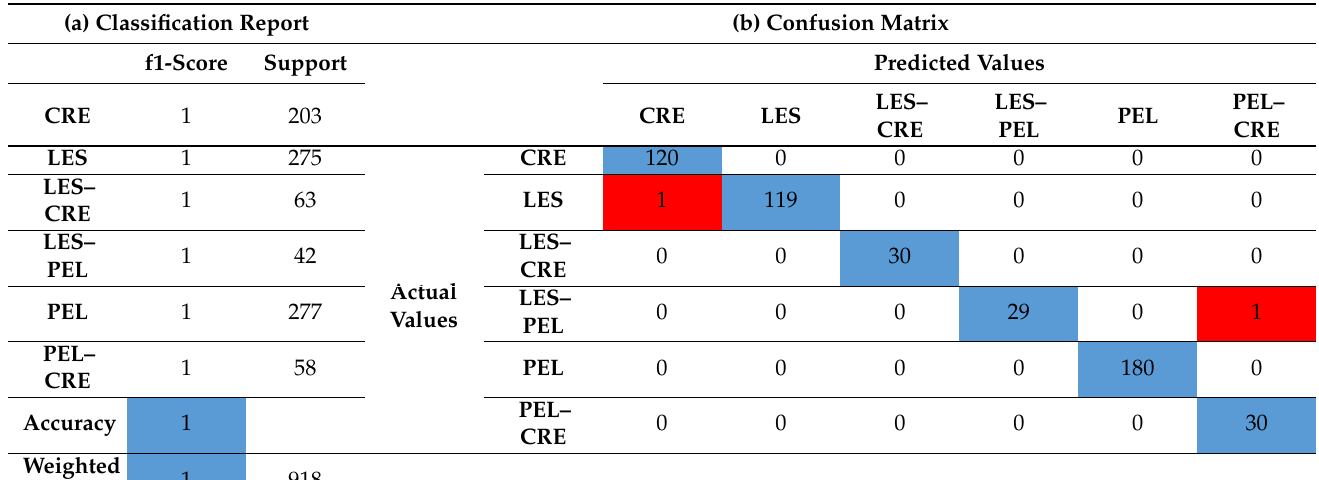
Table 2. ( a ) Classification report and ( b ) confusion matrix for SVC external